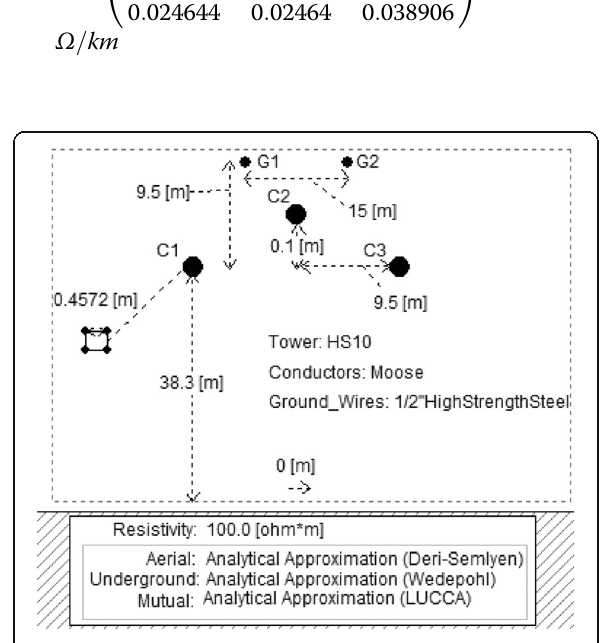
Fig. 7 400kV transmission line